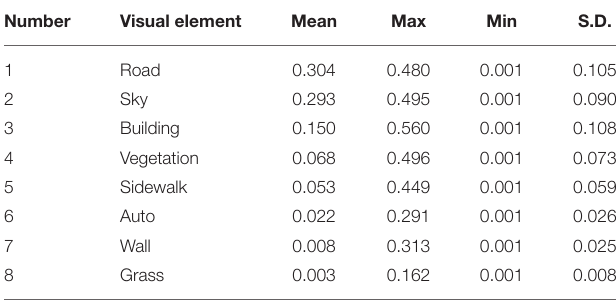
TABLE 4 | Statistics for the segmented results of the top eight GSVIs.